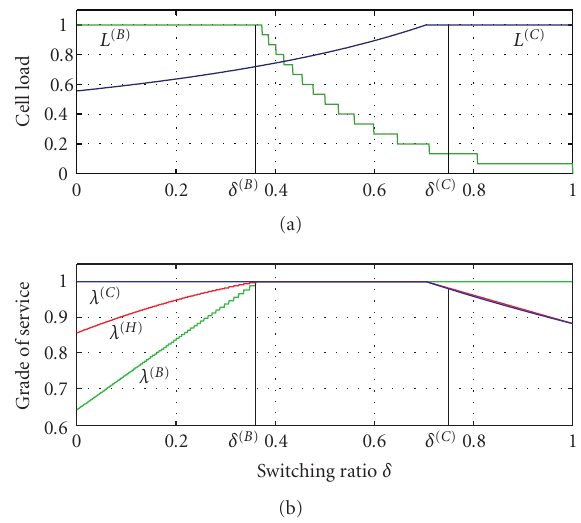
Figure 5: Performance indicators cell load and grade of service in a hybrid network for a single cell, depending on the switching ratio δ